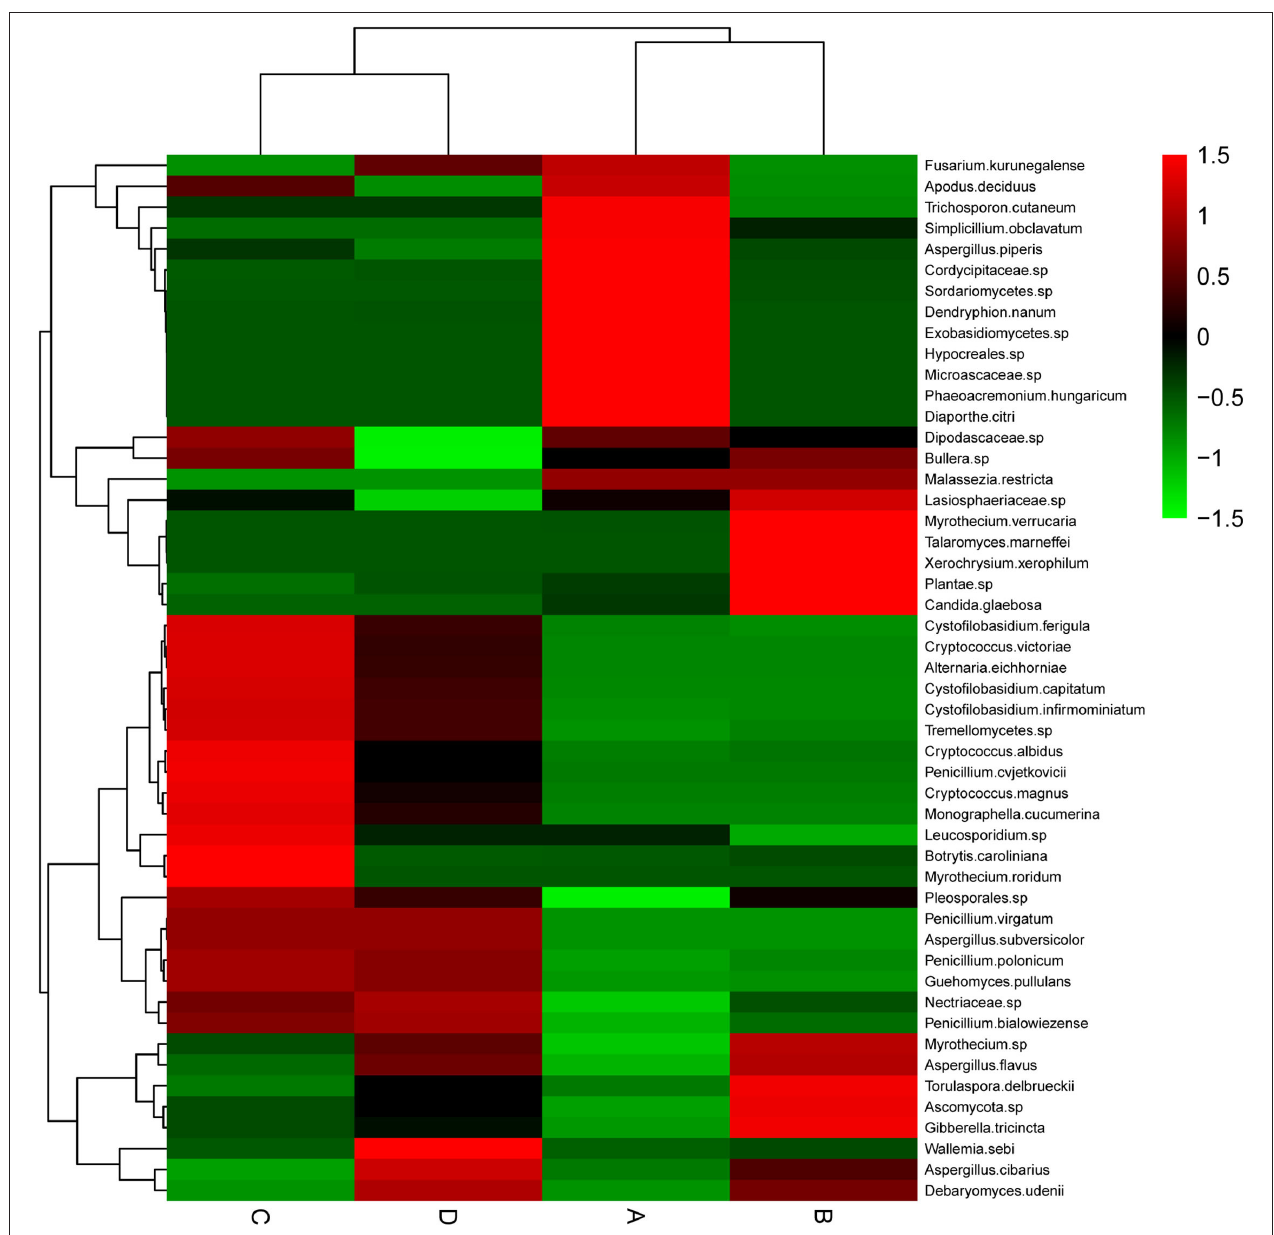
FIGURE 3 | Heat map of endophytic fungal community composition with cluster analysis. A. membranaceus samples under fermentation with E. faecium (A), L. plantarum (B), E. faecium + L. plantarum (C), and LBS (D) on day 6. Green and red colors stand for low and high abundances, respectively.